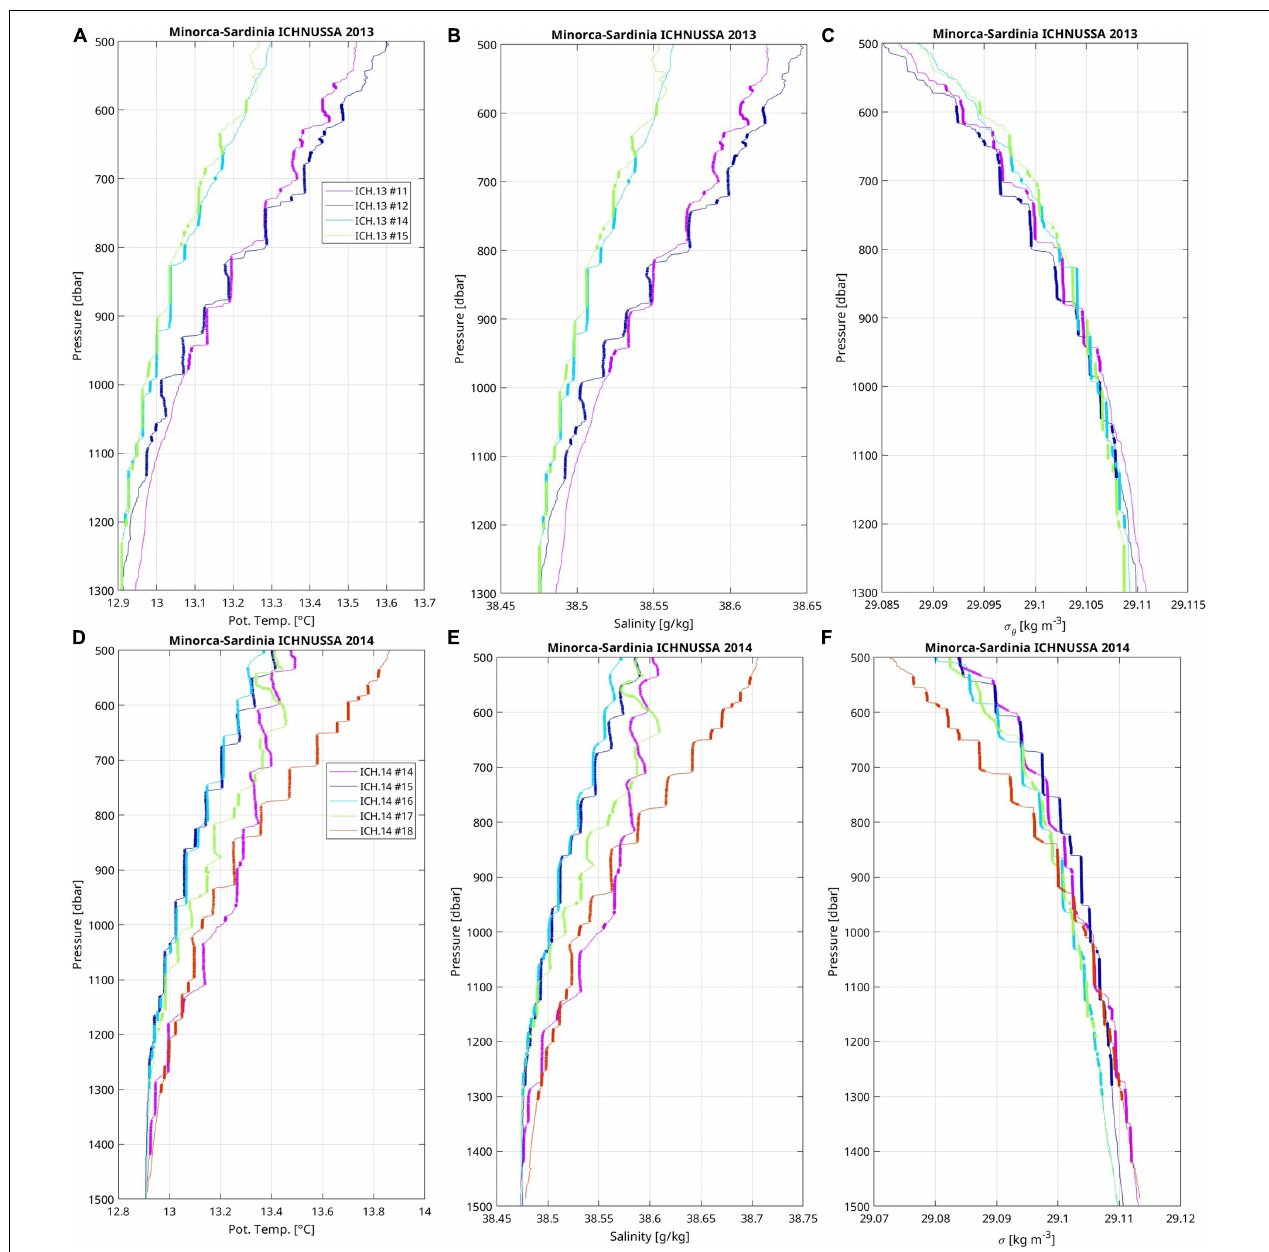
FIGURE 2 | Vertical profiles in staircases of (A,D) potential temperature, (B,E) salinity, and (C,F) potential density of stations located along the Minorca to Sardinia transect during (A–C) ICHNUSSA 2013, and (D–F) ICHNUSSA 2014 fall cruises. Station numbers are indicated in the figure legend (A,D) and located on the map ( Figure 1 ). Layers are emphasized by thick lines with weak vertical gradient